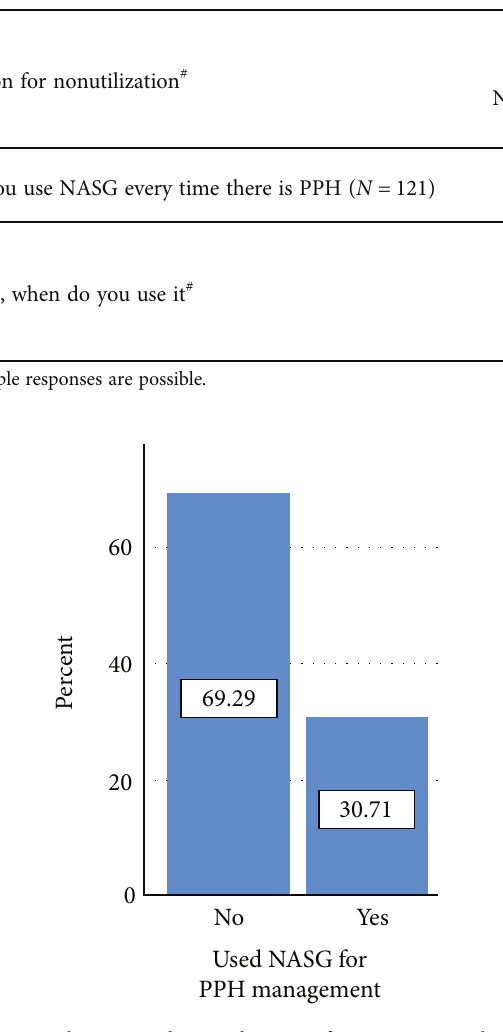
The last time an antishock garment was used ( N = 121